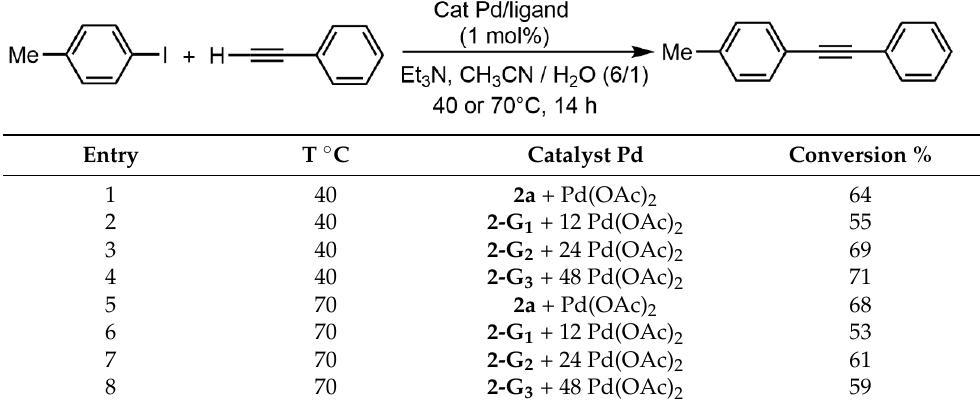
Table 3. Catalysis of Sonogashira couplings between iodotoluene and phenylacetylene.